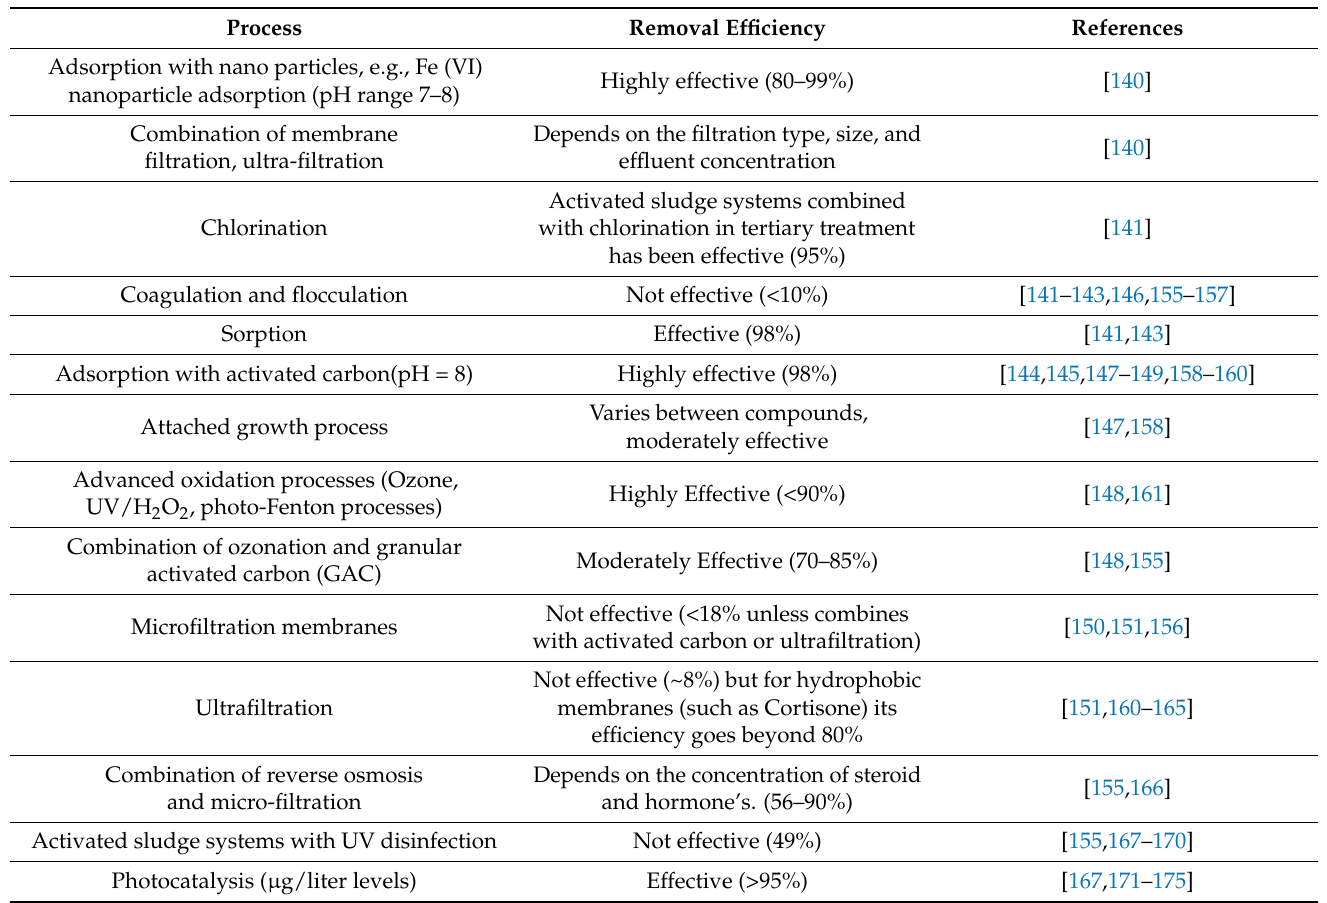
Table 4. Engineering processes and their efficiency for steroid and hormone